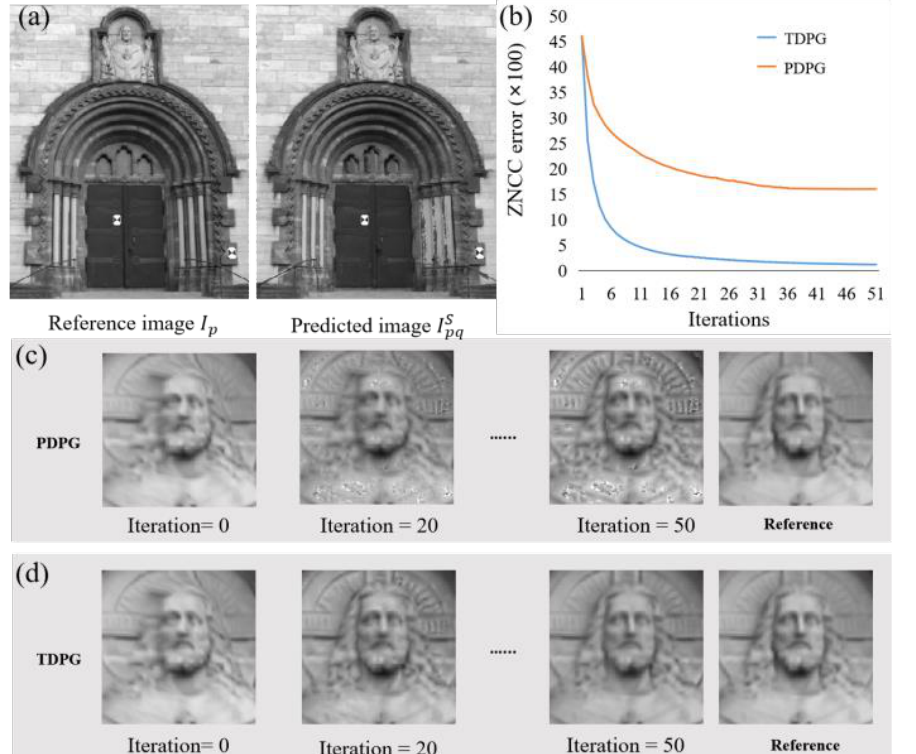
Figure 4. An example of the convergence process of PDPG and TDPG for the entire image. ( a ) shows the reference ( left ) and predicted image ( right ), and ( b ) shows the photo-consistency convergence curve of the PDPG and TDPG. ( c , d ) show the changes in the predicted image at different iterations by PDPG and TDPG, respectively.